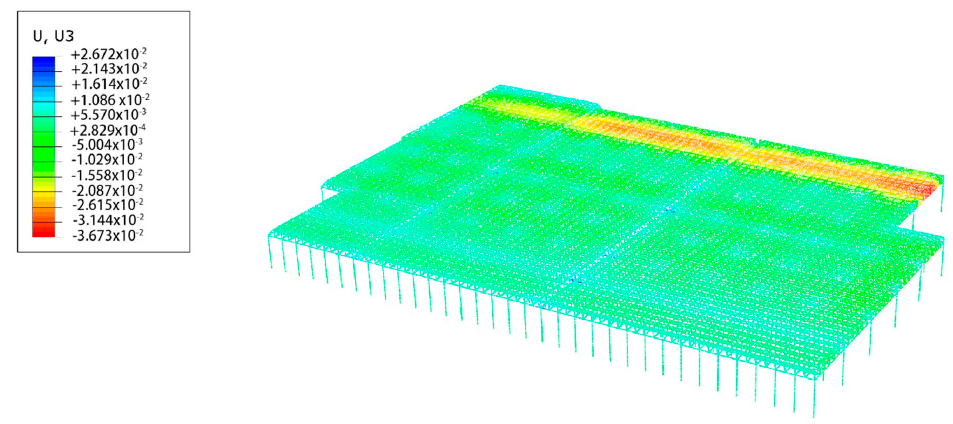
Figure 20. Displacements in the short-edge direction caused by load and thermal effects in the space frame and steel-reinforced concrete column system.